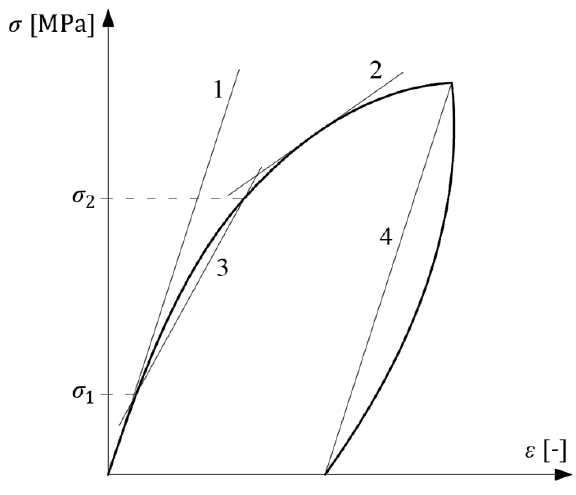
Figure 1: Graphical interpretation of Young’s moduli of